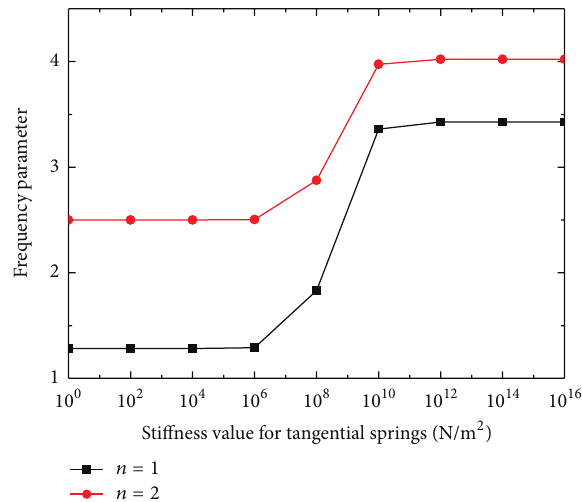
Figure 4: The effects of normal boundary spring stiffness on frequency parameters.